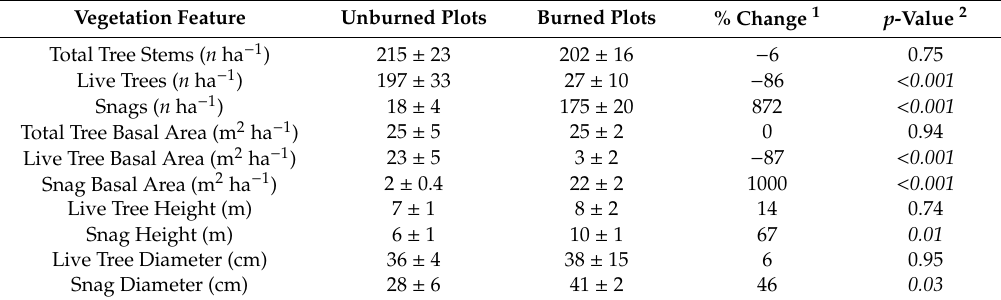
Figure 4. Maps of the four plots whose photographs (Figure 3) were used to represent field conditions. Colors were used to identify species, and solid symbols were used to represent dead (Stump, Snag, Log) and live (Seedling, Sapling, Tree) stems. Table 1. Characteristics (mean ± standard error) of sampling plots inside (“Burned”) and outside (“Unburned”) the 2000 fire